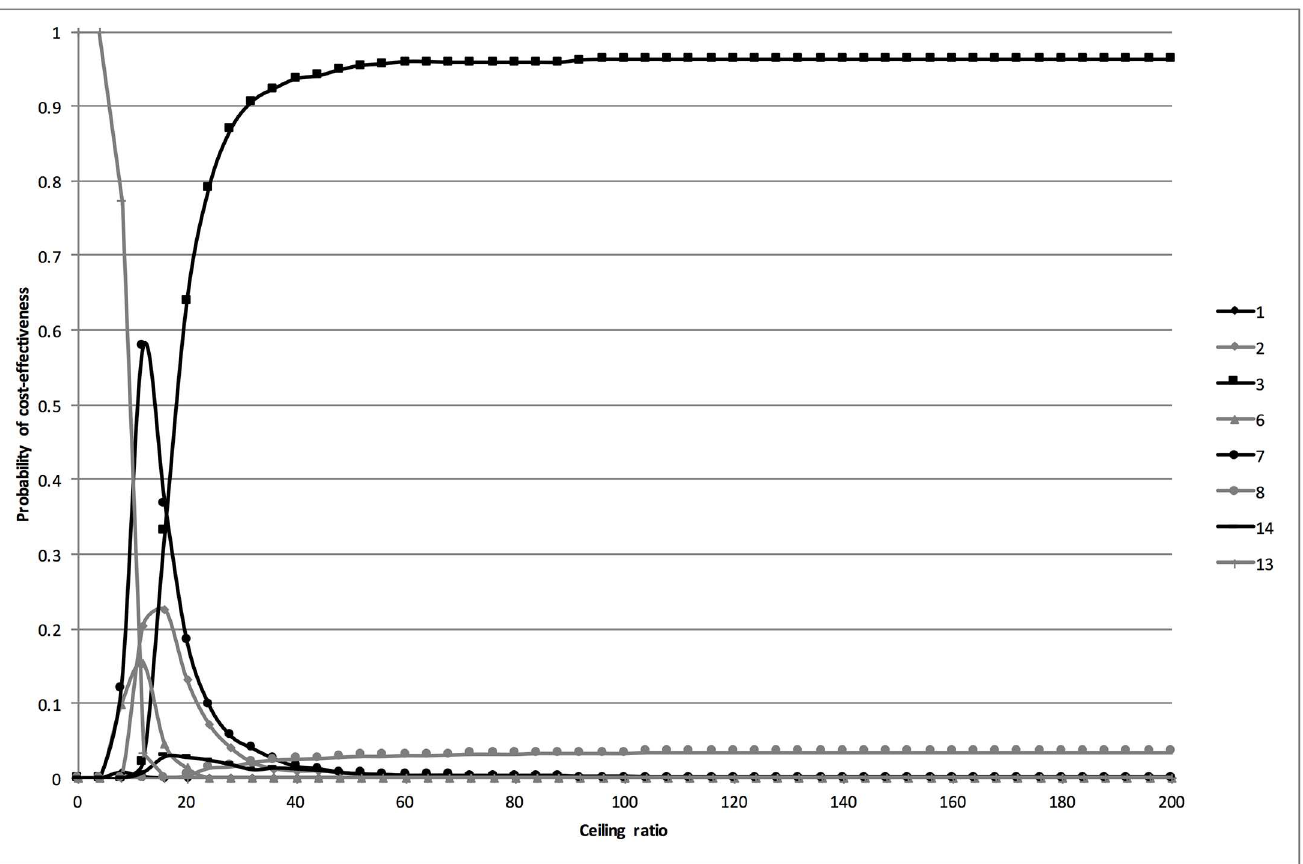
Fig 3. Cost-effectivenessacceptability curves for the analysis excluding the dipslide. The cost-effectiveness acceptability curves are basedon the probabilistic analysis. They show the probabilitythat the different diagnostic strategies are cost-effective at a range of ceilingratios.